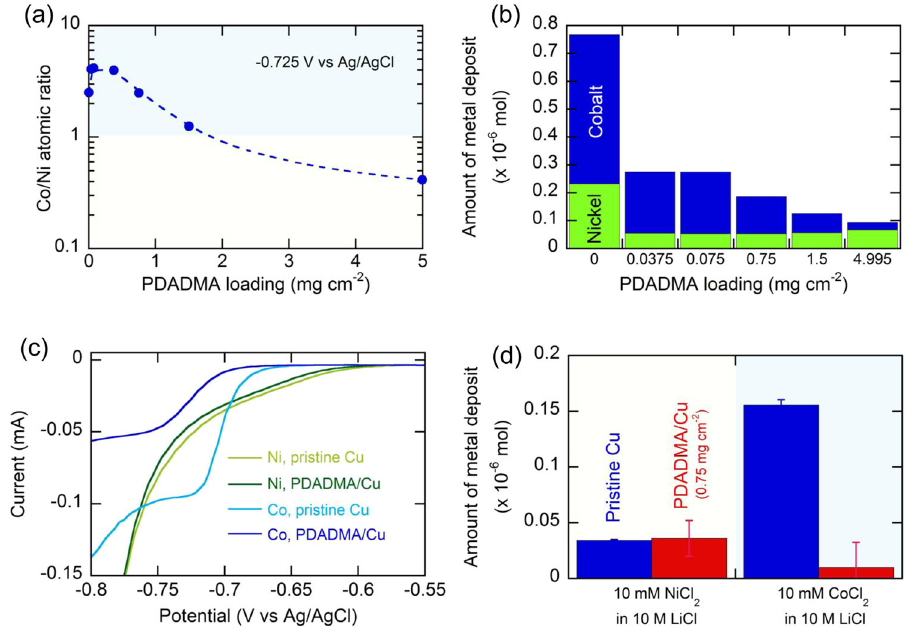
Fig. 3 Selectivity tuning in the electrodeposition of cobalt and nickel enabled by interfacial charge control with a positive polyelectrolyte, PDADMA. The effect of PDADMA loading on a the surface Co/Ni ratio on the electrodeposit and b the actual amount of cobalt and nickel electrodeposited. − 0.725 V vs Ag/AgCl was applied for 0.5 h. c Linear sweep voltammograms of a single metal salt of 10 mM Co(II) or Ni(II) in 10 M LiCl using pristine Cu and PDADMA-loaded Cu (PDADMA loading: 0.75 mg cm − 2 ) at a scan rate of 5 mV s − 1 . d The actual amount of cobalt and nickel electrodeposited in a single metal salt of 10 mM Co(II) or Ni(II) in 10 M LiCl using pristine Cu and PDADMA-loaded Cu (PDADMA loading: 0.75 mg cm − 2 ). − 0.725 V vs Ag/AgCl was applied for 0.5 h in d . Error bars indicate standard error of the mean ( n =